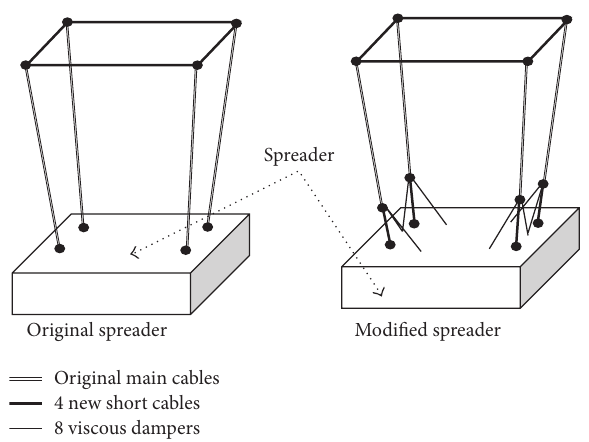
Figure 1: Modified spreader to implement the cable damper